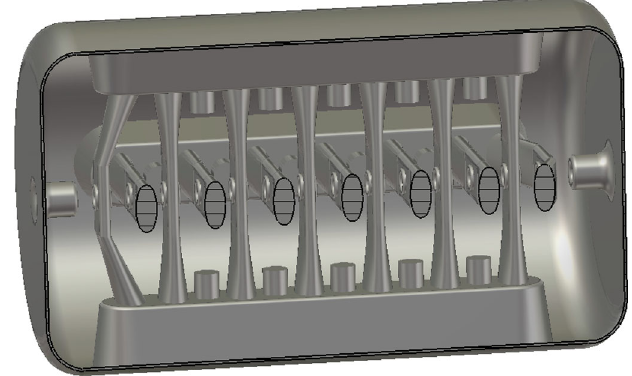
FIG. 8. Preliminary layout of the 217 MHz CH cavity for the cw heavy ion linac for an injection energy of 1.4 AMeV.